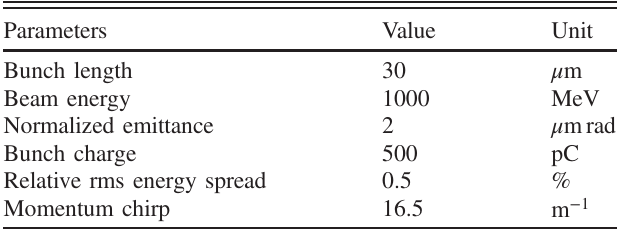
TABLE I. Parameters of the ELEGANT simulation for conven- tional rf